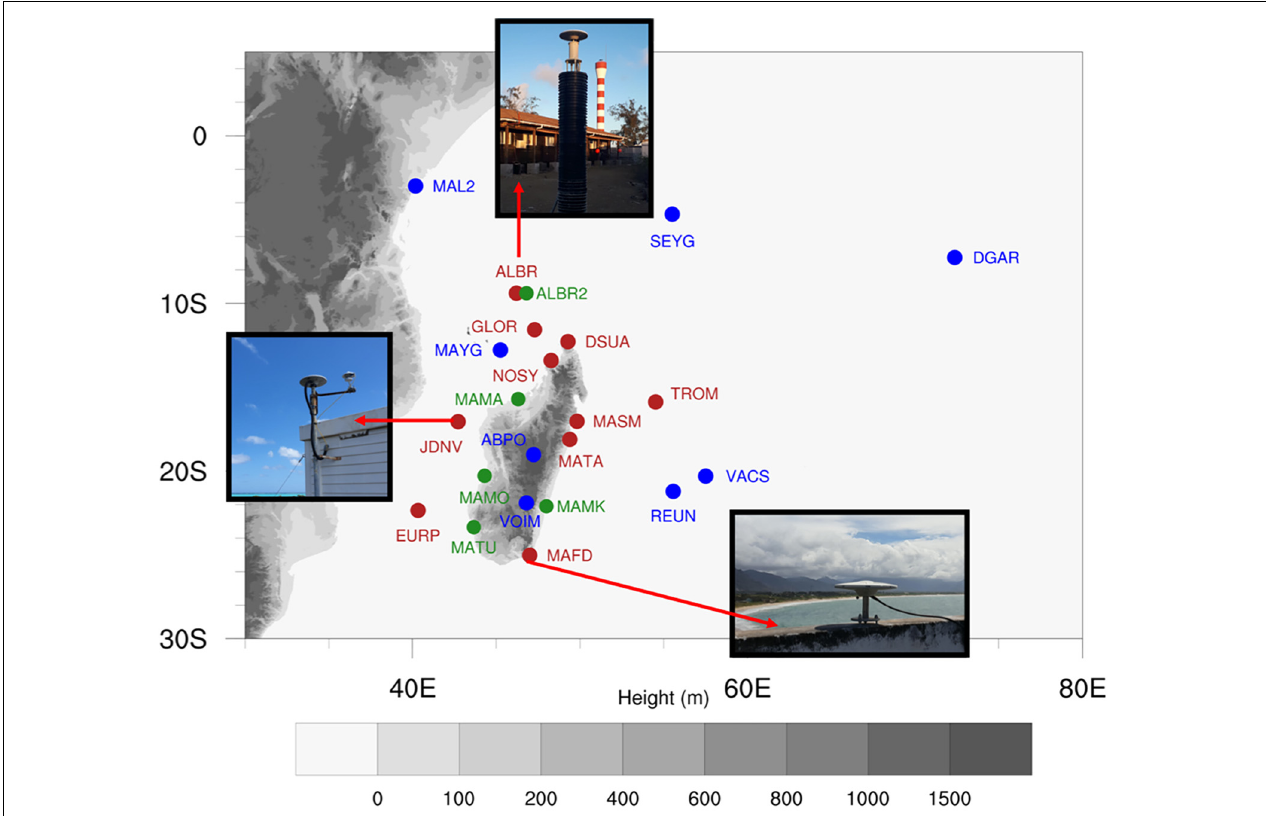
FIGURE 1 | Location of public GNSS stations available in the SWIO superimposed on terrain height (gray shaded). Blue dots indicate IGS stations while red (resp. green) dots show current (resp. future) IOGA 4 MET stations, respectively. The inserts show pictures of GNSS stations deployed at Aldabra (11/2017), Fort-Dauphin (07/2018) and Juan de Nova